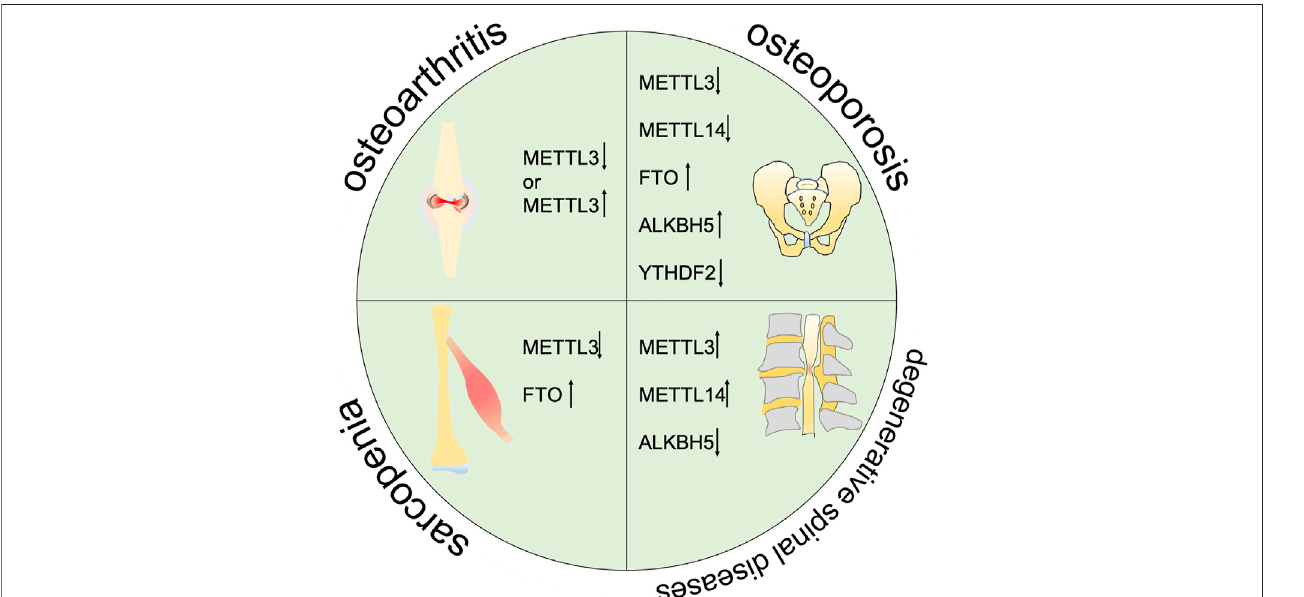
FIGURE 2 | m 6 A is correlated with the progression of multiple degenerative diseases including osteoarthritis, osteoporosis, sarcopenia, and degenarative spinal diseases.